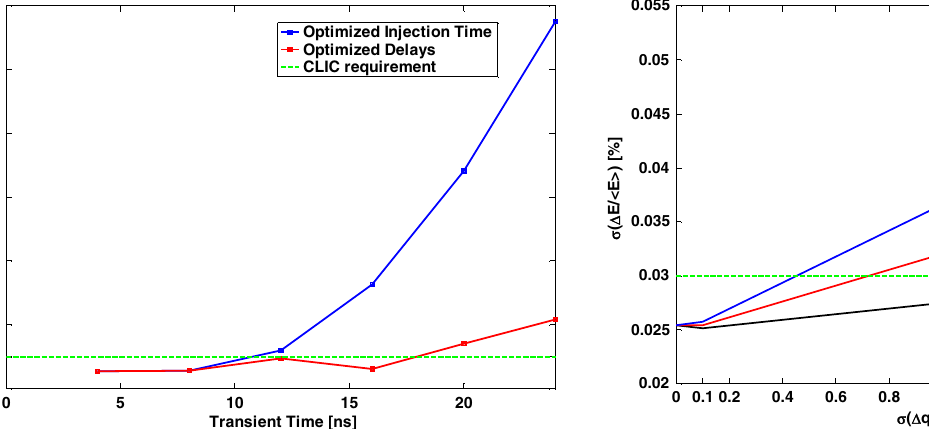
FIG. 23. Effect of influence of the main beam charge jitter on the energy spread.